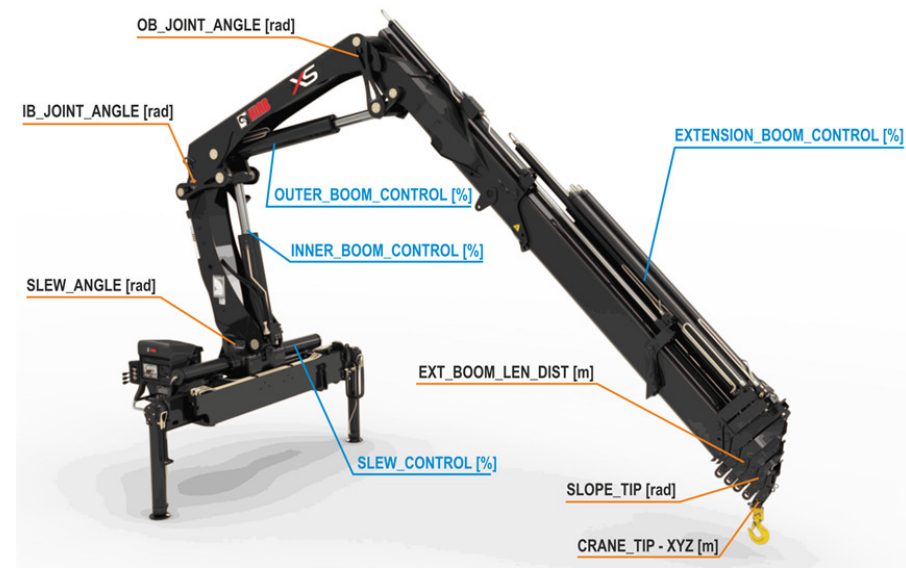
Figure 13. HIAB example crane (http://hidrauline-kelimo-technika.enax.lt/hiab-xs-211-pro/).